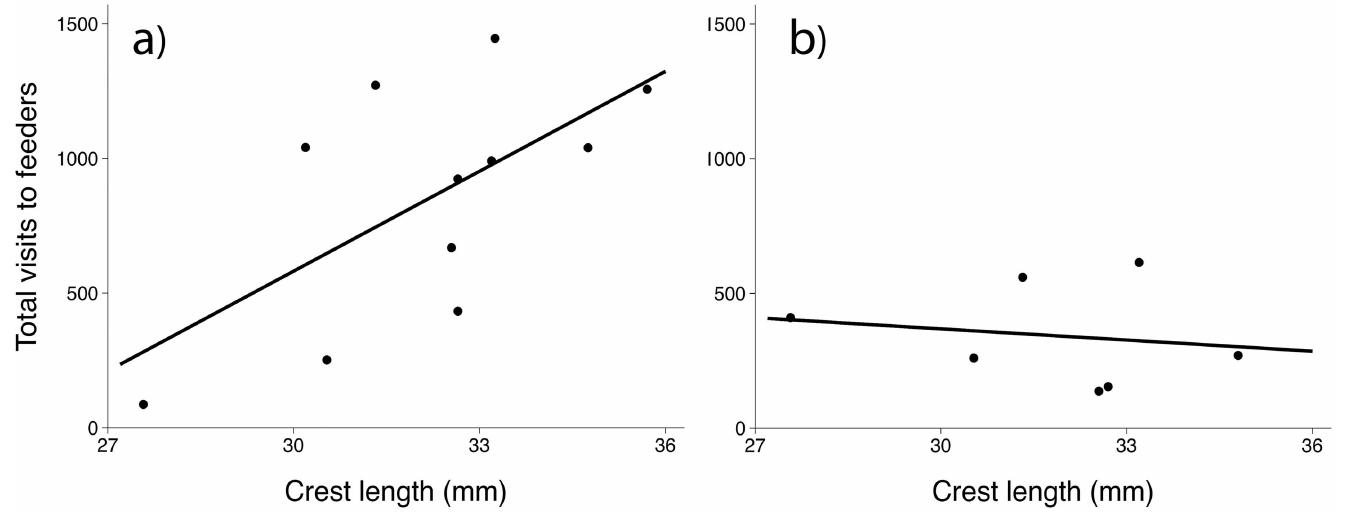
Fig 2. Relationship between male crest length and accessto supplemental feeders, as assessedby total visits to feeders. (a) duringthe high- density periodwhen the value of feeders is assumed to be high, and (b) duringthe low-density periodwhen the value of feeders is assumed to be low.